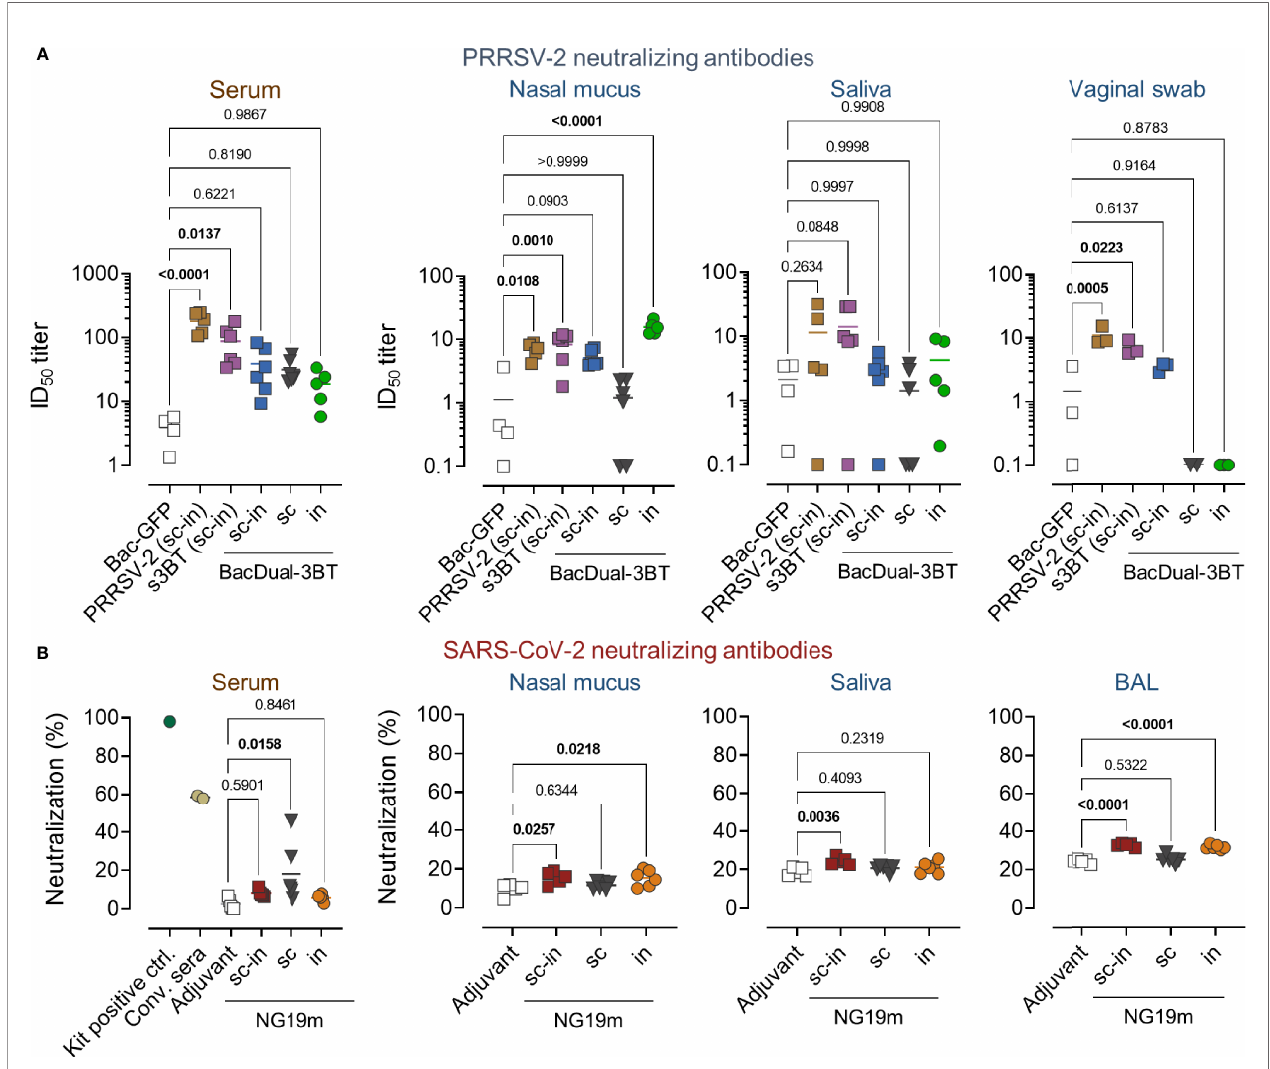
FIGURE 6 | Soluble 3BT, BacDual-3BT, and NG19m elicit a variable neutralizing antibody response against the target viruses in serum and mucosal fl uids. The neutralizing activity of serum and mucosal samples, collected at day 56 of the immunization scheme in PRRSV-2 and SARS-CoV-2 experiments, was assessed. (A) The ability of serum and mucosal samples to interfere with PRRSV-2 infection was measured via in-cell ELISA. MARC-145 cells grown in 96-well plates were incubated with each sample dilution-virus mixture (100 TCID 50 ). The anti-N monoclonal antibody SDOW-17 was utilized to detect N protein in fi xed and permeabilized cells. The half-maximal inhibitory dilution (ID 50 ) is presented for each sample. Antibiotics (penicillin, streptomycin, and gentamycin) were added to DMEM at standard concentrations to avoid bacterial contamination (see materials and methods), as sera and mucosal fl uids were not sterile. (B) SARS-CoV-2 neutralizing capacity of serum and mucosal samples was assessed by quantifying the inhibition of ACE2-RBD interaction using the cPass GenScript kit. The percentage of neutralizing capacity of samples is presented. Samples were not further titrated as their neutralizing capacity was low. Differences in ID 50 titers or percentage of neutralization were analyzed applying ordinary one-way ANOVA followed by Dunnett´s multiple comparisons test (comparison with the negative control group). The mean from each group is indicated by a horizontal line. The serum graphic shows the percentage of neutralization values of the kit´s positive control and two convalescent sera, which were run in parallel with all the